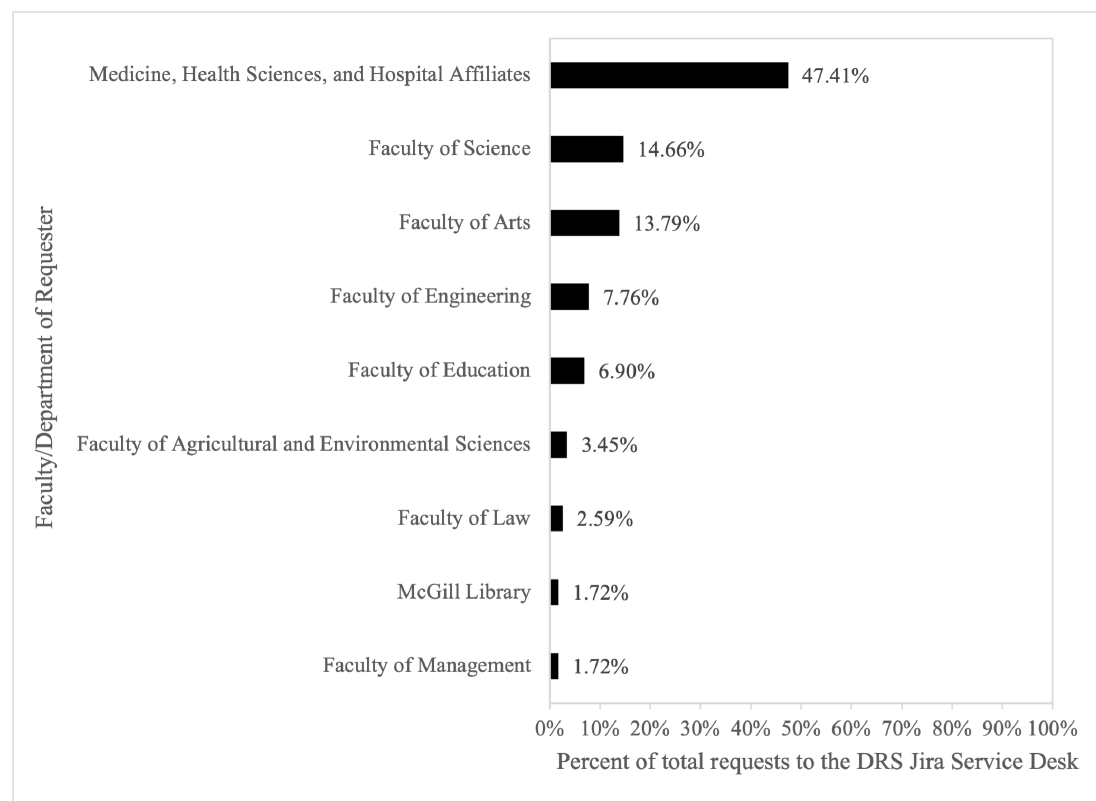
Figure 4 : Percent of total requests to Digital Research Services Jira Service Desk by Faculty or Departmental Affiliation, 2021-2022. Note: medical and health science faculties and departments have been